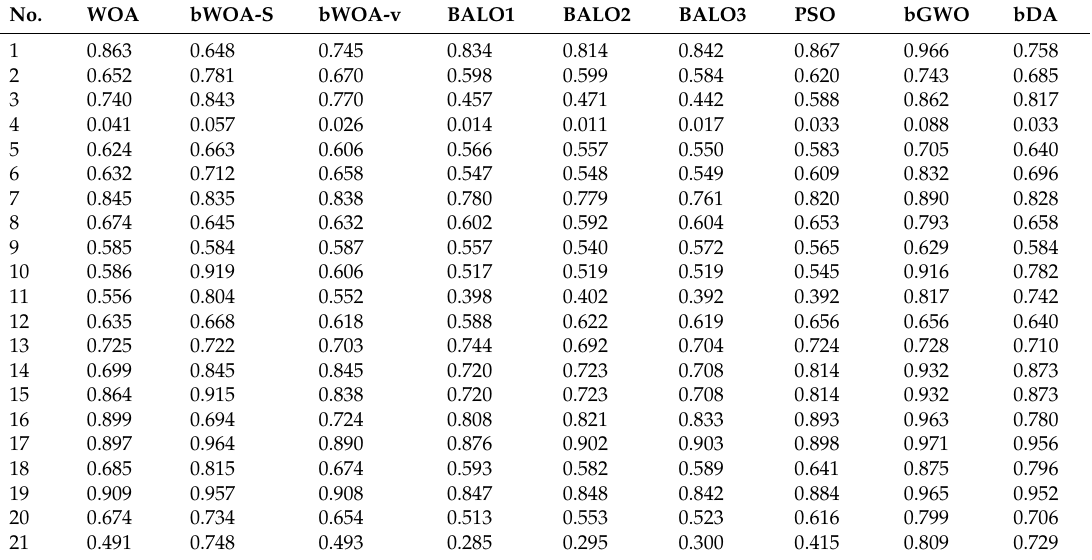
Table 4. Average classification accuracy for the compared algorithms on the different datasets using small